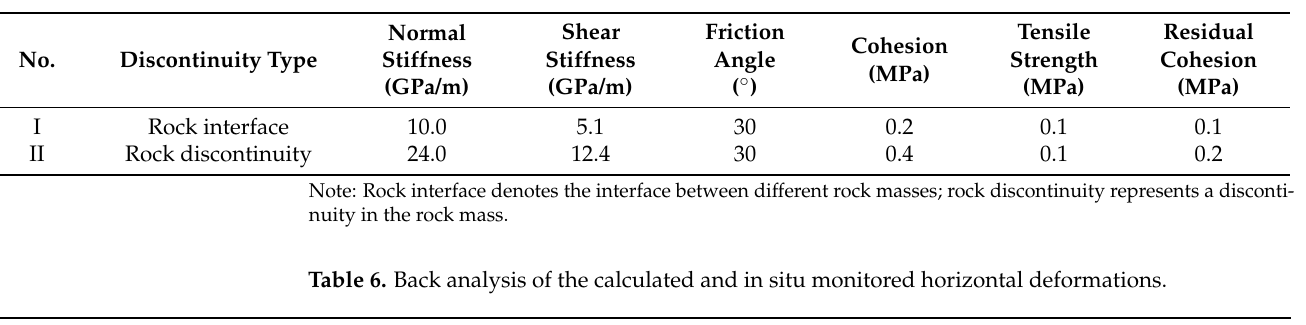
Table 5. Mechanical parameters of the discontinuities.